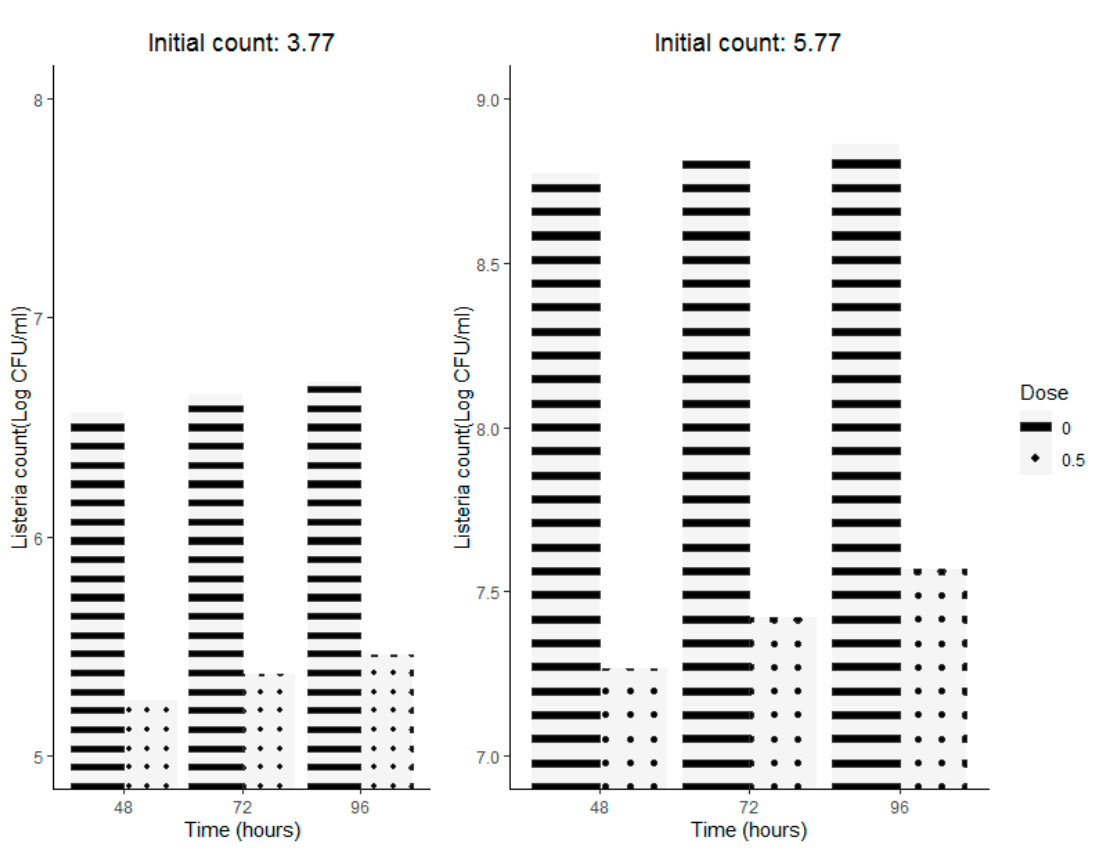
Figure 3. Growth of Listeria monocytogenes ATCC 19116in cold-stored (6 °C)milk inoculated at two different initial bacterial loads (3.77 and 5.77 Log CFU/mL) and supplemented with thyme aqueous extract (0.5 mg/mL).